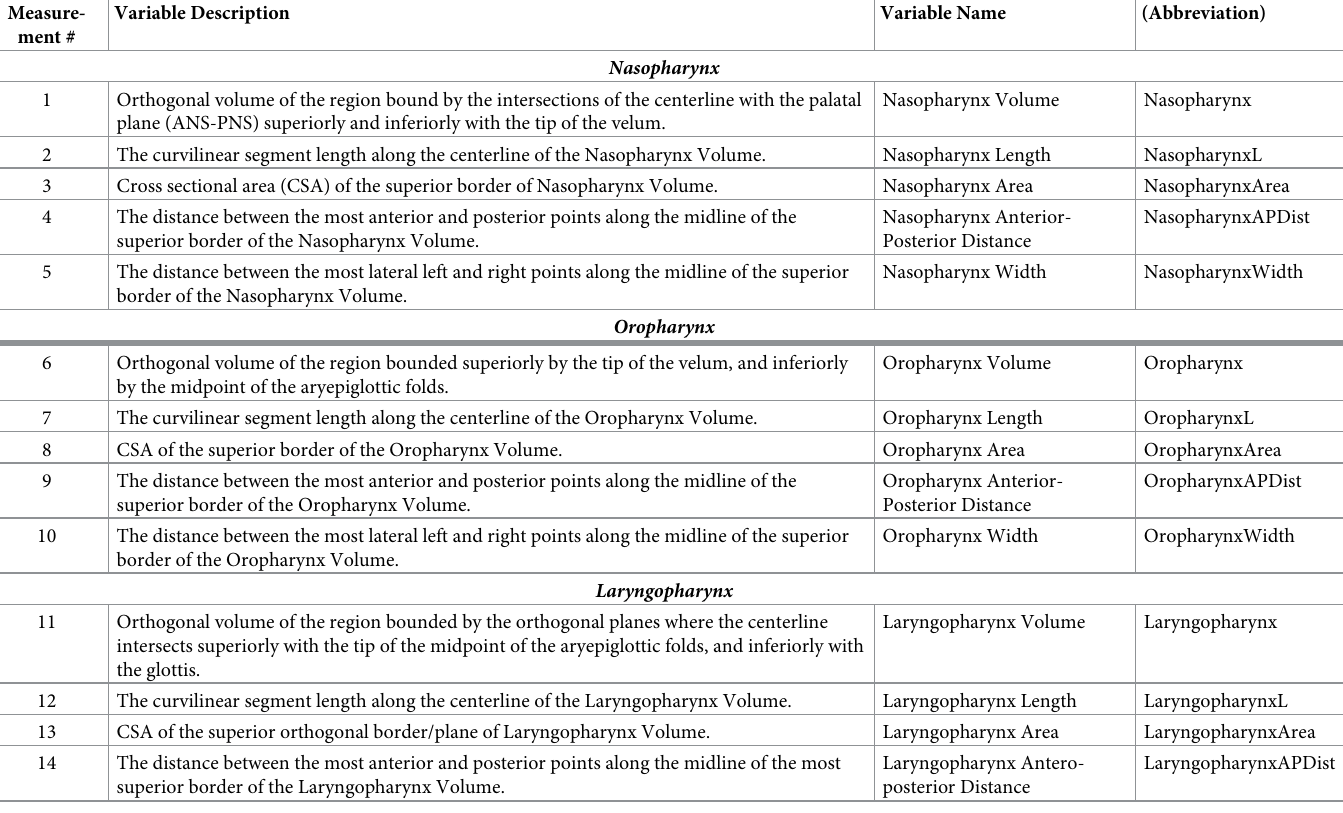
Table 5. All upper airway variables